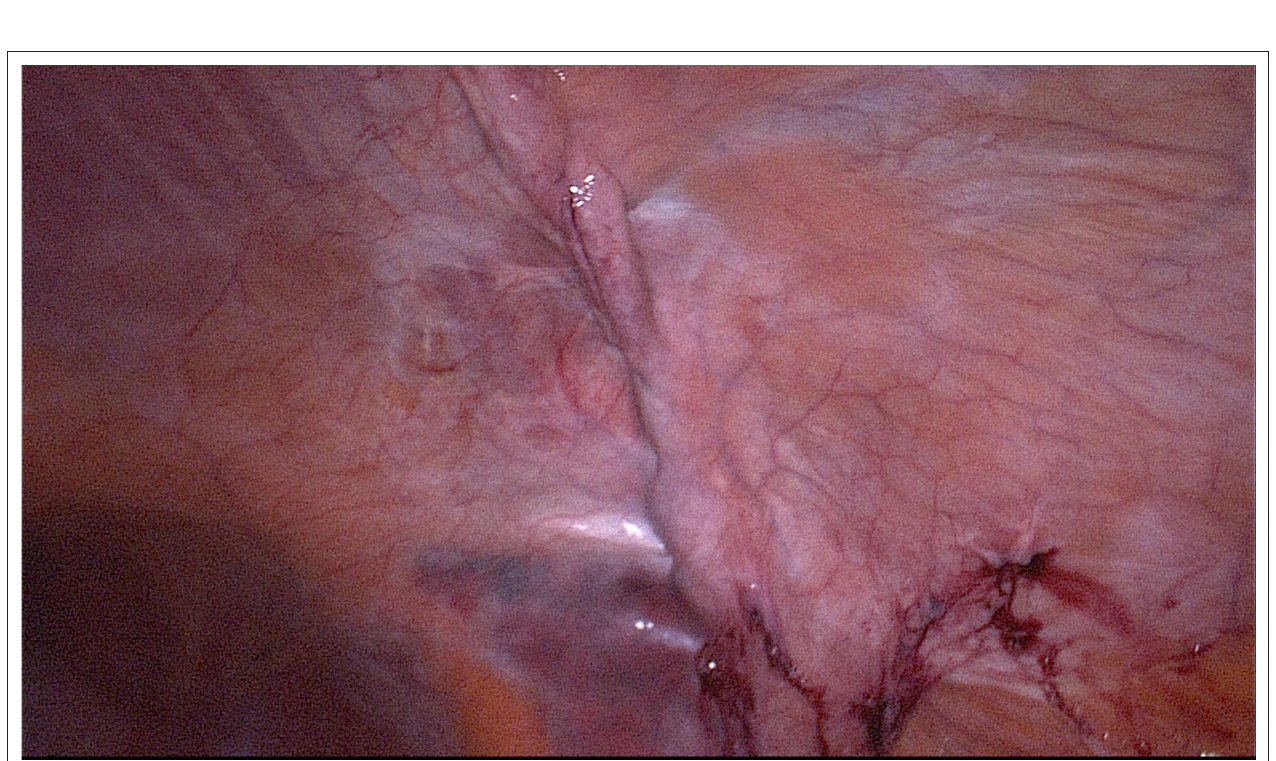
FIgure 4 | Intraabdominal view on the former hernia. The fascial gap is has been closed with a running